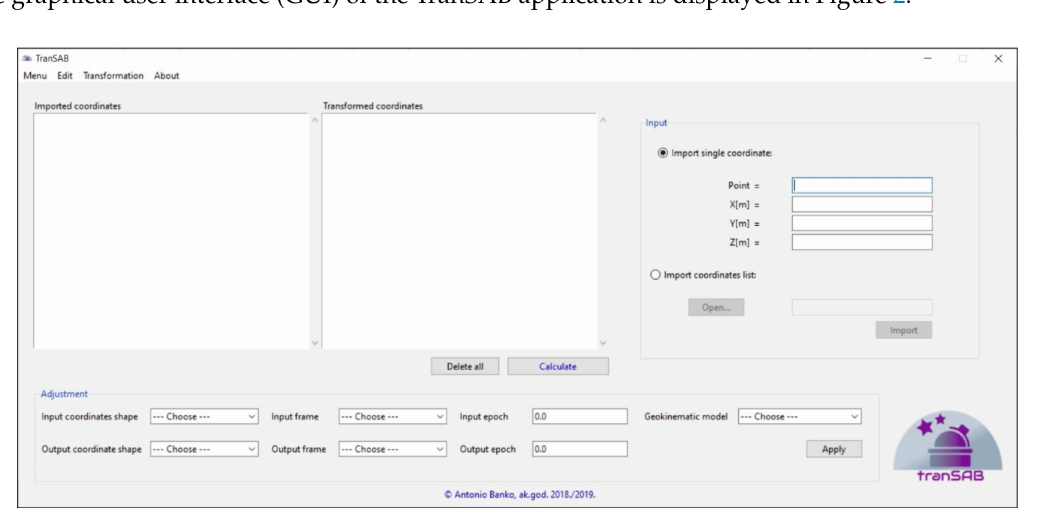
Figure 2. The TranSAB graphical user